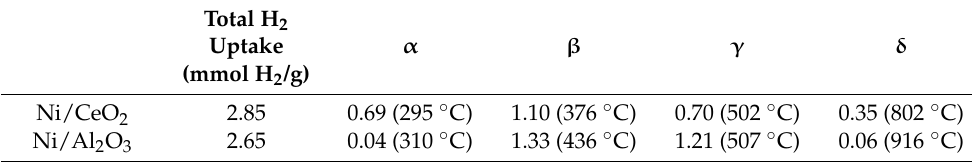
Table 2. Redox properties of the Ni/CeO 2 and Ni/Al 2 O 3